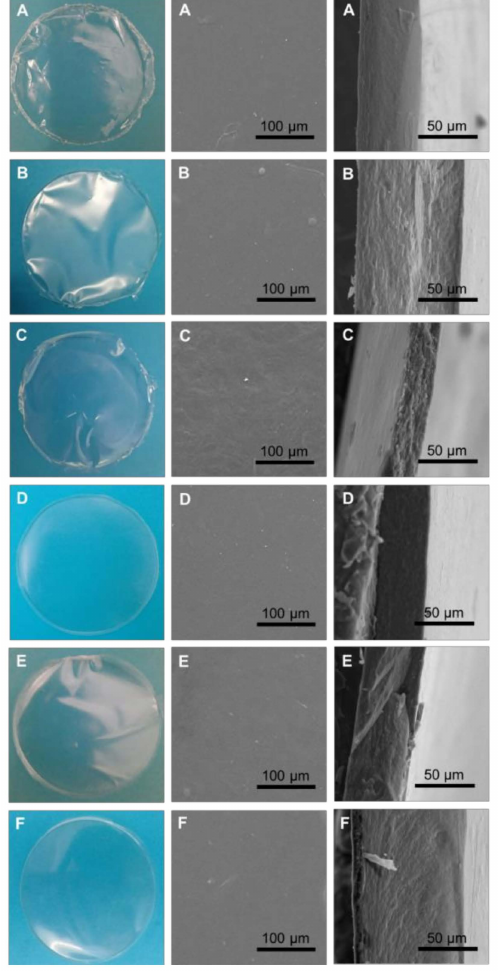
Figure 2. Photographs of the films prepared with Alteromonas EPSs ( A – F ) (left panel) and scanning electron microscopy images: top view (centre panel) and cross-section view (right